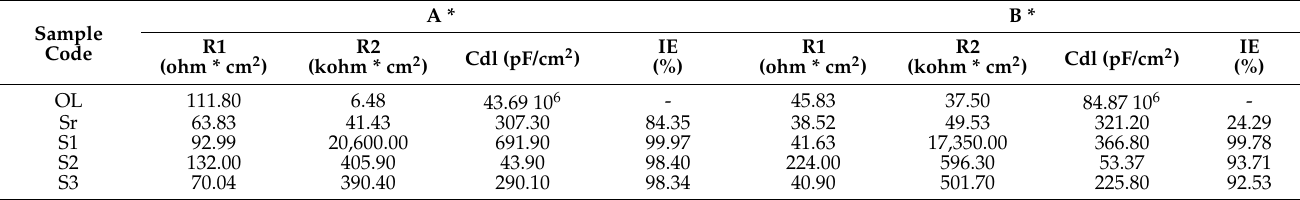
Figure 9. Nyquist plots after accelerated corrosion test in 3.5% NaCl solution at 25 °C. Table 4. Electrochemical parameters obtained from EIS Table 4. Electrochemical parameters obtained from EIS measurements.